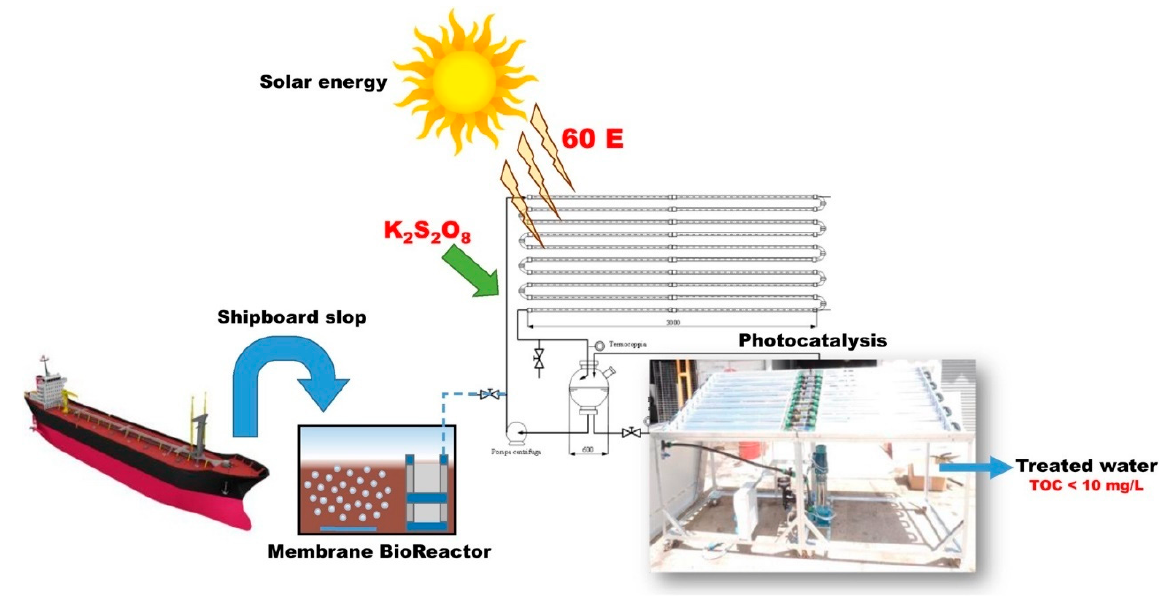
Figure 8. Combination of MBR and photocatalytic reactor (PCR) for treatment of shipboard slop water. Reprinted with permission from ref. [155]. Copyright 2019 Institution of Chemical Engineers.